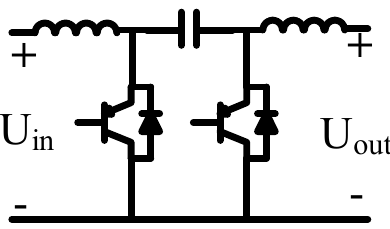
Figure 8. Topology of Cuk bidirectional DC/DC converter.